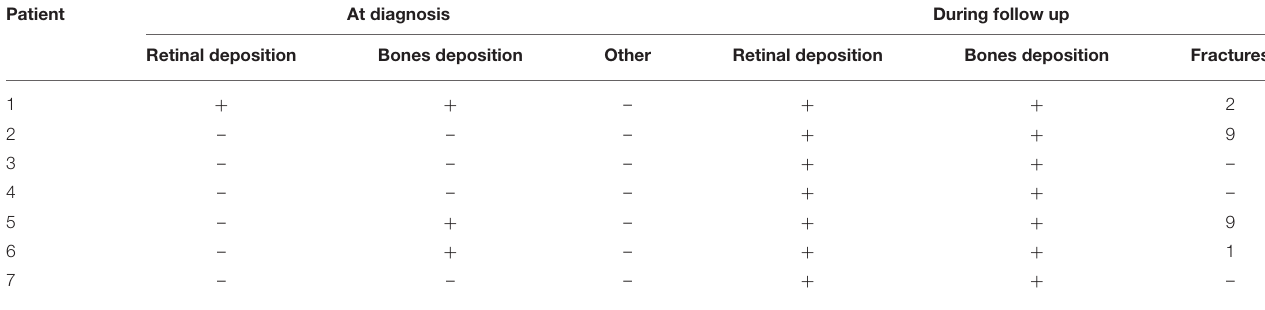
TABLE 4 | Extra-renal complications of